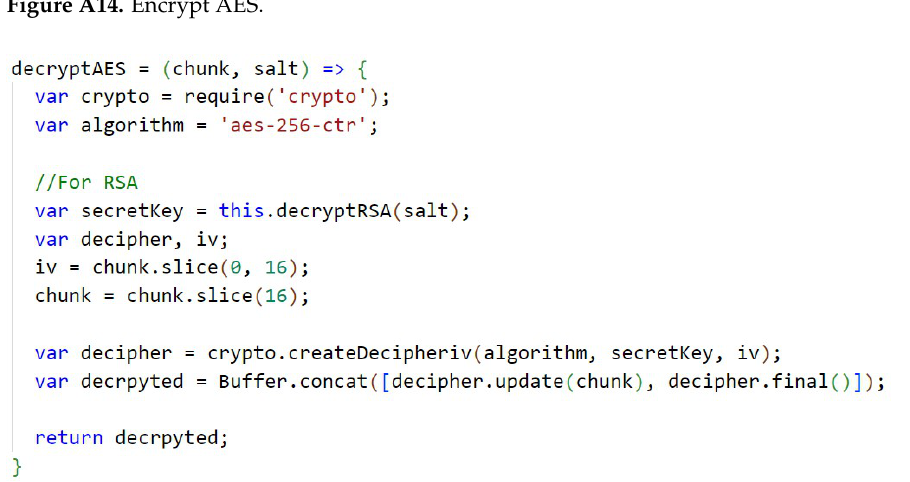
Figure A14. Encrypt AES.